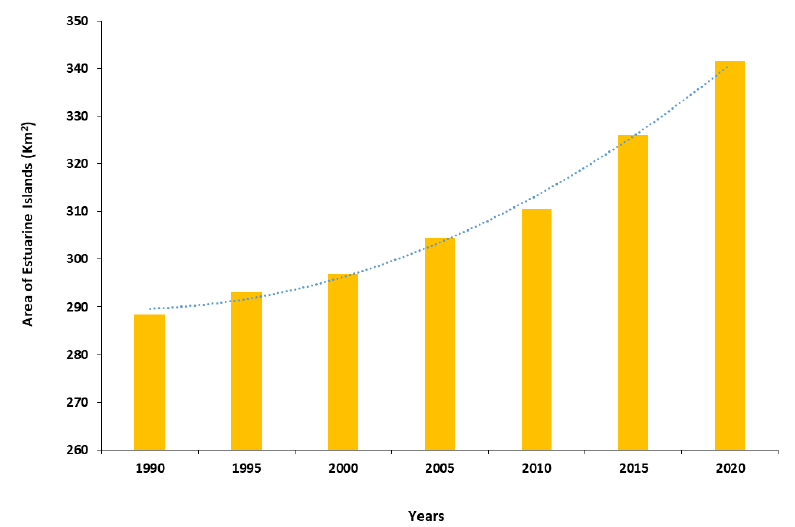
Figure 9. Change in the areal extent of the estuarine islands between 1990 and 2020.